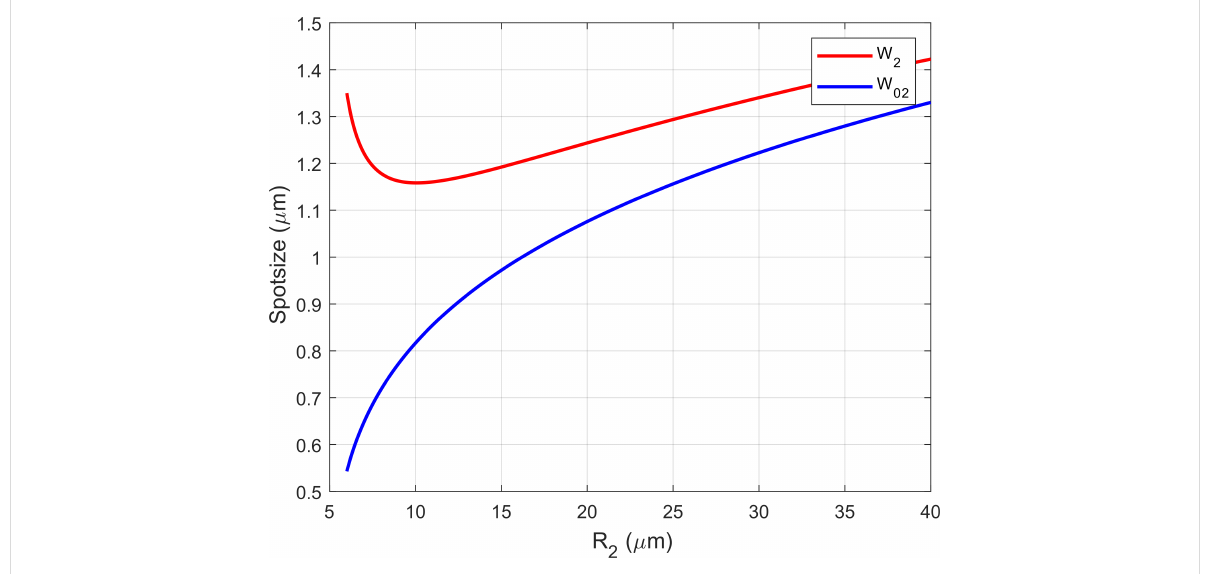
Figure 5: Transverse cut of Figure 4 through length L 2 = 5.03 μ m to show dependence of R 2 with spotsizes. As the values of R 2 diminishes, while maintaining a constant L 2 , the functions for W 02 (blue) and W 2 (red) start to diverge, arriving at the limit of the paraxial approximation (stability regime).